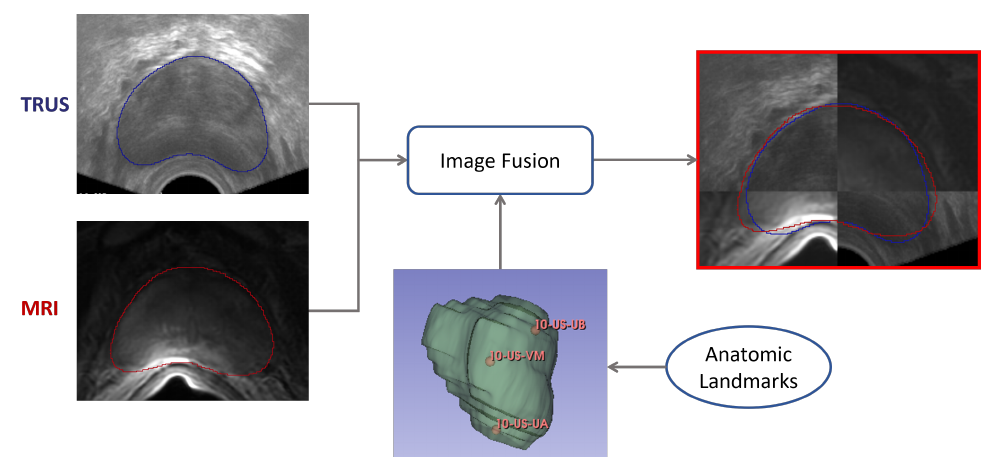
Figure 10. Workflow employed for the image-fusion procedure. Segmentation masks are obtained for both domains—TRUS and imaging. Then, the registration is performed as described in Section 2.5, so that images can be fused. Both masks are shown after the registration